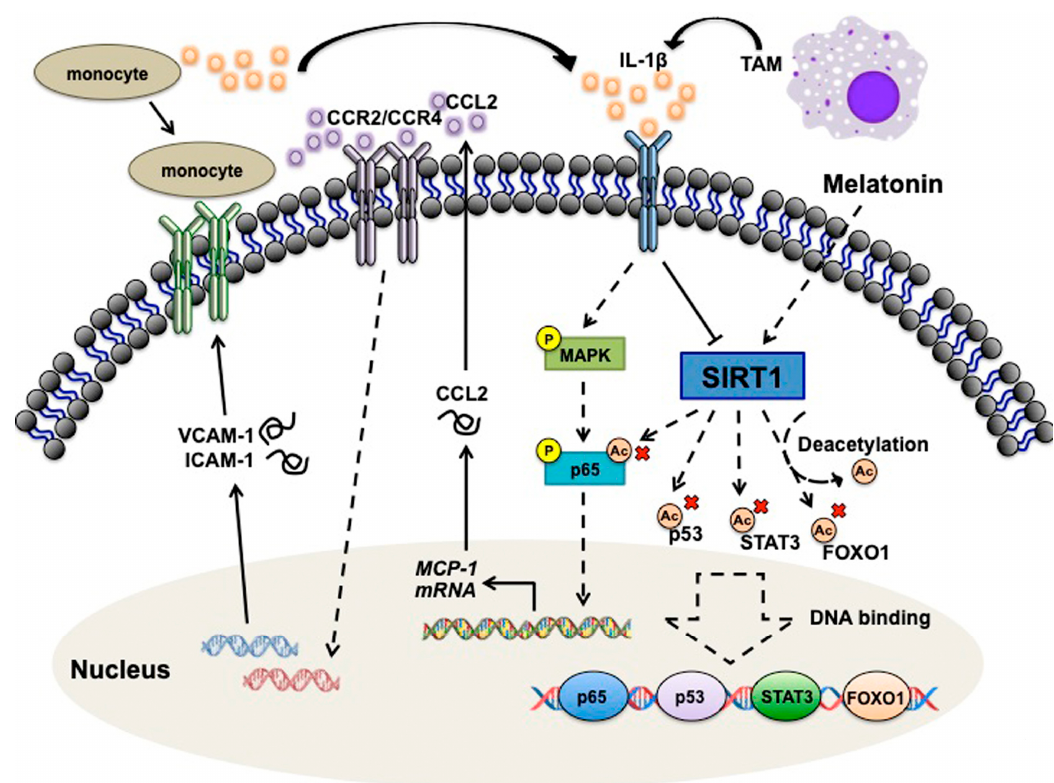
Figure 8. Schematic diagrams of the signaling pathways which are involved in the SIRT1 modulates microenvironment of GBM. IL-1 β releases from tumor-associated macrophage, then activates the p38 and p65 signaling. This results in an accumulation of NF-kB in the nucleus which further enhances CCL2 expression. GBM secretes CCL2 and further modulates VCAM-1 and ICAM-1 expressions via CCR2 and CCR4 axis. The VCAM-1 and ICAM-1 expression on GBM surface then subsequently enhances monocyte binding to GBM. The adherent monocyte then secretes more IL-1 β to stimulate cancer cells to form a positive feedback loop. Melatonin could induce SIRT1 upregulation and attenuate cytokines and adhesion molecules expression.